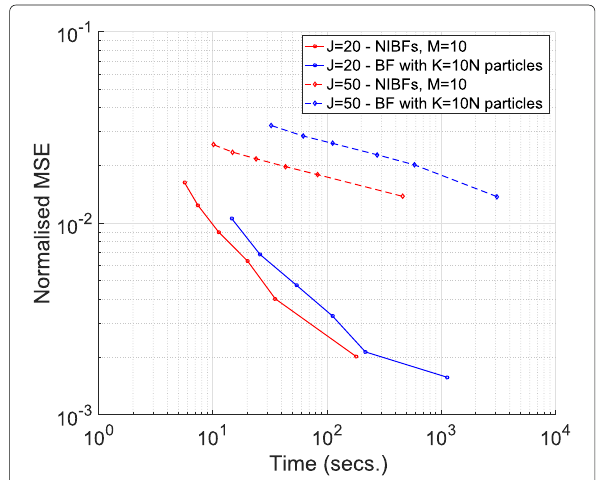
Fig. 5 Empirical mean of the normalised MSE versus the running time for the centralised BF with K = 10 N particles and the ensemble of M = 10 NIBFs with N = 20,40,80,160,320,1600 particles each. Results are shown for a Lorenz 96 system with J = 20 variables (solid lines) and a Lorenz 96 model with J = 50 variables (dashed lines).